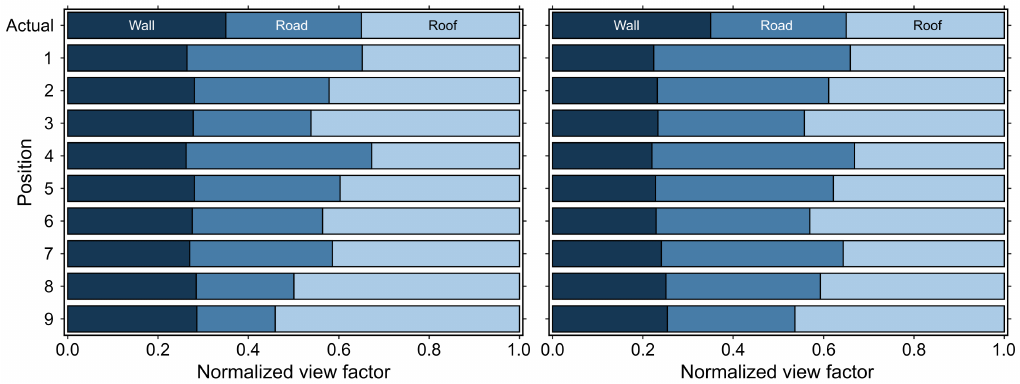
Figure A2. Normalized wall, road, and roof view factors for nine sensor positions viewing the simplified street canyon array from 2.17 ( left ) and 3 ( right ) times mean building height. The lower sensor height was chosen to represent the height of the pyrgeometer above the Sperrstrasse street canyon. The slightly higher height was chosen to represent view factor proportions one would expect with the same sensor placed at a more ideal height as suggested in Adderley et al. [10] and Roberts [38]. Actual normalized view factors refer to surface area proportions for the three facet types in the Sperrstrasse street